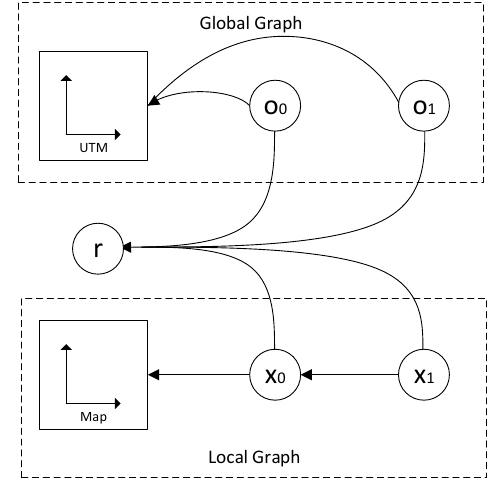
Figure 3. Processing pipeline of the pose graph merging